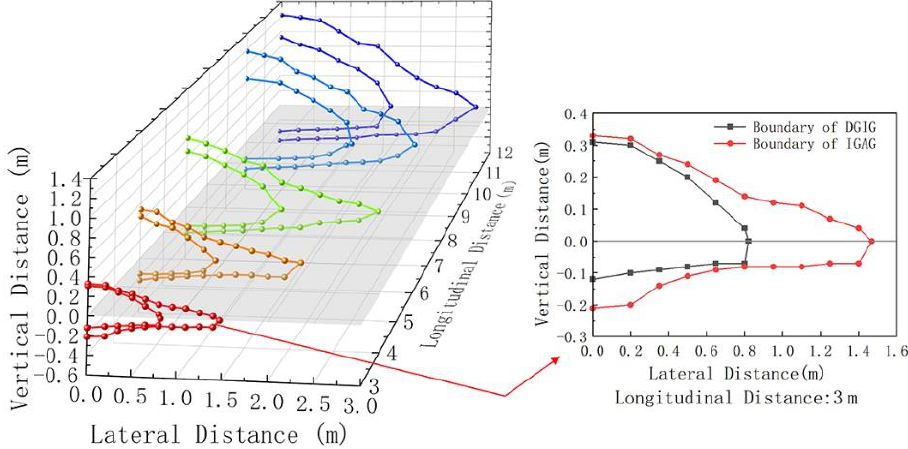
Figure 11. Cutoff curves of DGIG and IGAG.